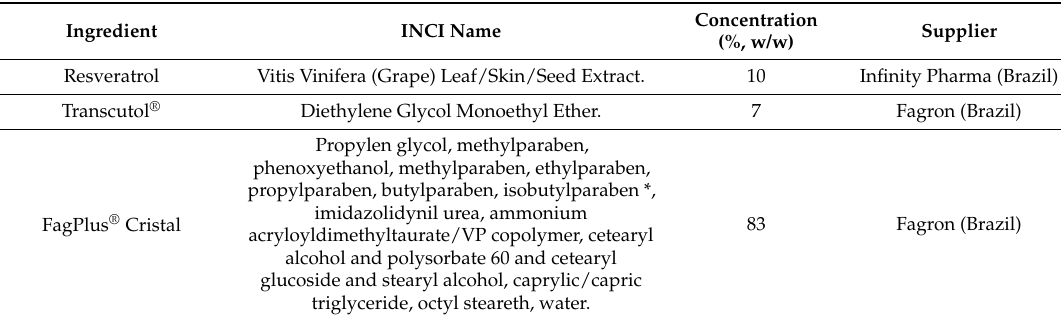
Table 1. Composition of the liquid crystal-based emulsion with